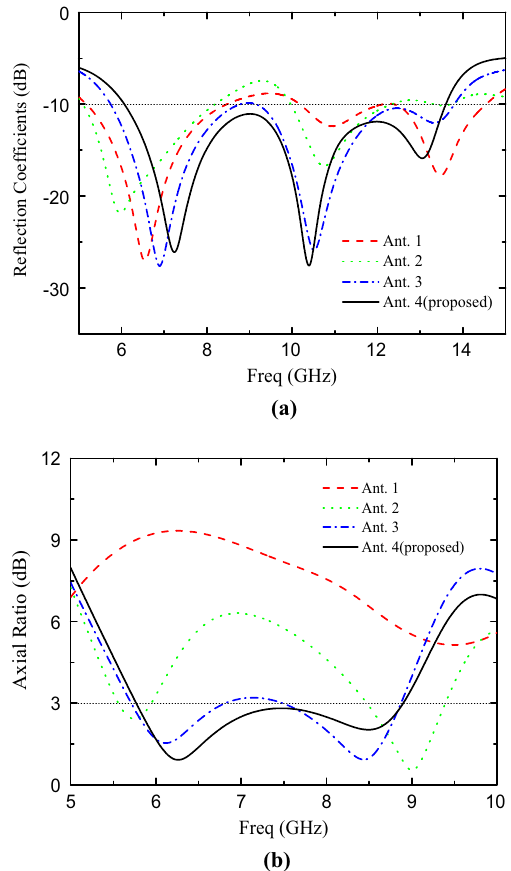
Fig. 3 Performance comparison of the four designed antennas. a The relationship between the frequency and the reflection coefficient. b The relationship between the frequency and the axial ratio